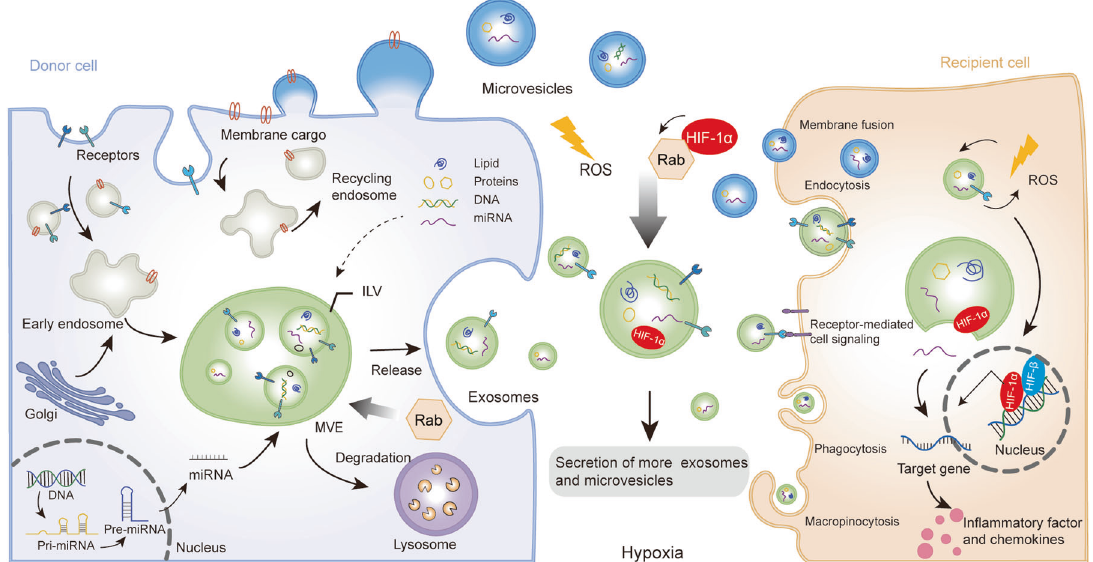
Fig. 1 Biogenesis, secretion, and uptake of EVs. Microvesicles are generated after formation by budding from the plasma membrane. Exosomes are essentially intraluminal vesicles(ILV), which are formed in multivesicular endosomes (MVE). Cargoes sorting to MVEs originate from endocytosis at the plasma membrane or to early sorting endosomes. Proteins are transported from the Golgi or internalized from the cell surface, and nucleic acid can be endocytosed and transferred into the early endosomes. Then early endosomes maturate into MVE, which follows either the secretory or degradative pathway. Microvesicles are secreted upon the fusion of MVEs with the cytomembrane. Extracellular vesicles (EVs) may also be internalized by multiple pathways, such as direct signaling through ligand/receptor molecules, the direct fusion of their membrane, endocytosis, macropinocytosis, and even phagocytosis. MicroRNA carried by EVs can uptake into receptor cells and combine with target genes to regulate in fl ammatory response. Hypoxia can activate HIF-1 α signaling and alter the biogenesis of EV, and Rab GTPases and ROS are also involved in this